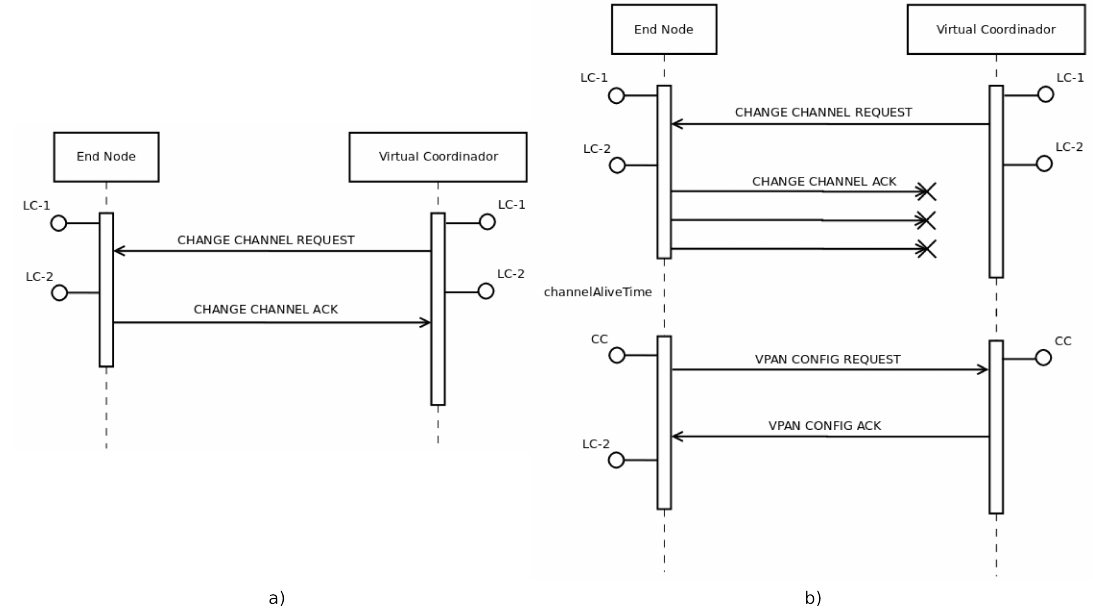
Figure 4. Message flow for channel migration. ( a ) normal flow; ( b ) flow with